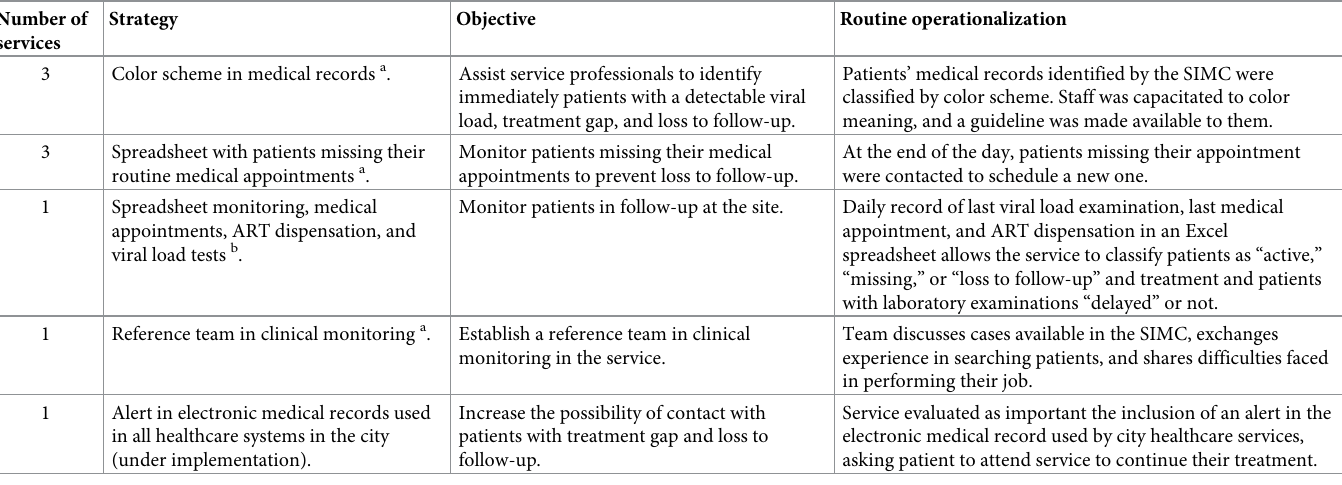
Table 5. Strategies tailored for health care professionals to identify PLHIV with a detectable viral load, treatment gap, and lost to follow-up (LFU).